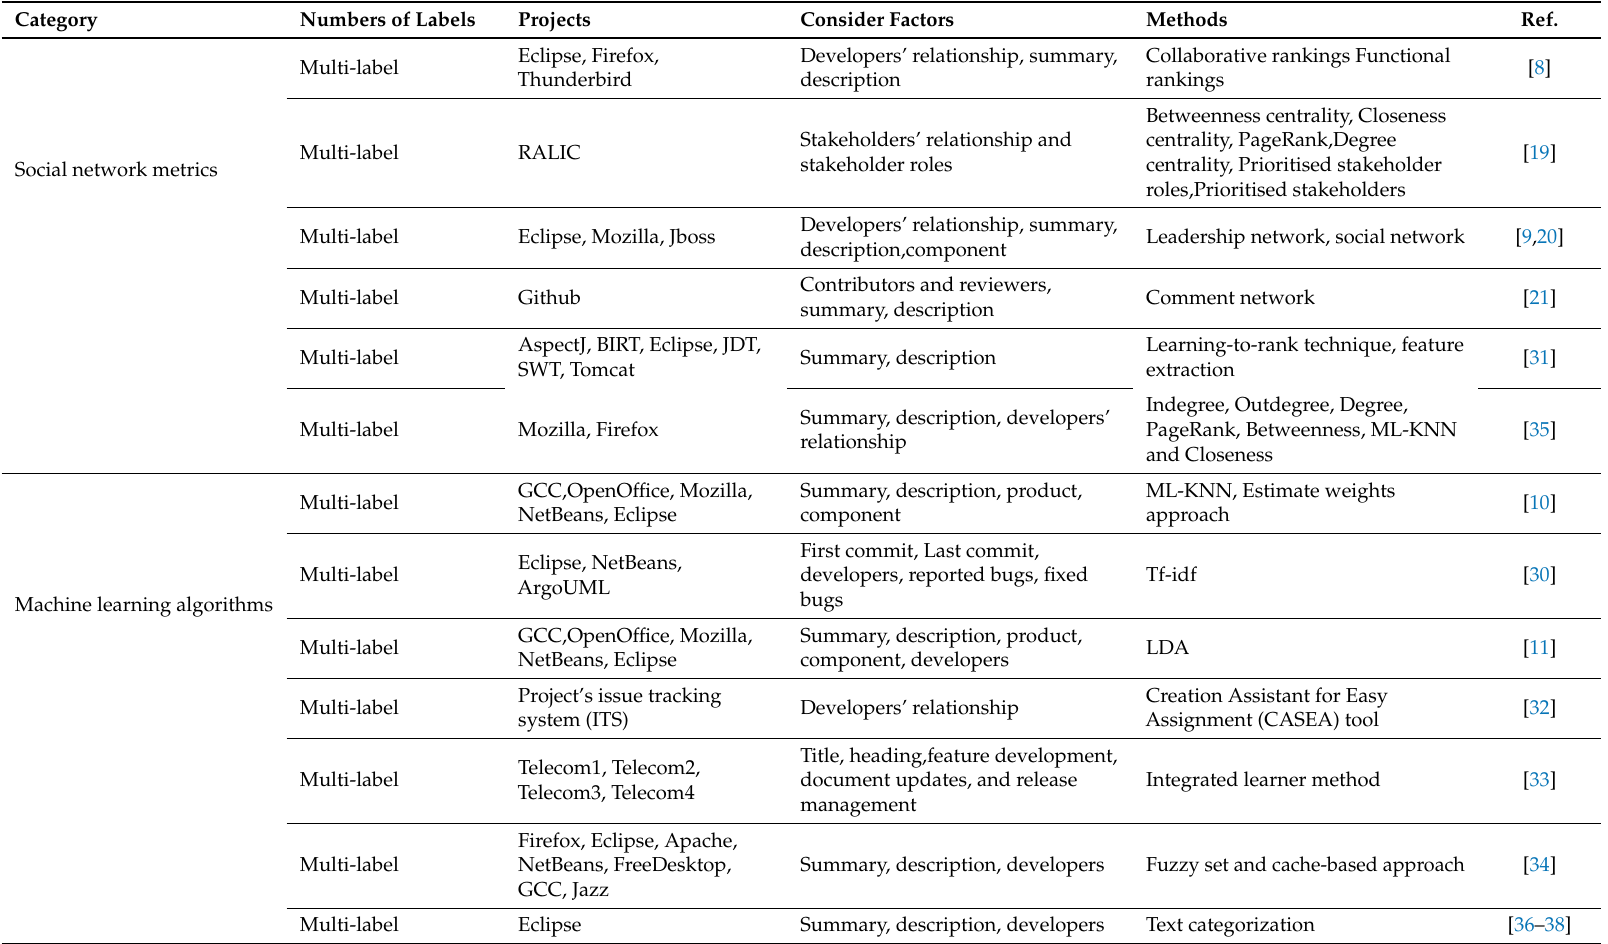
Table 1. An overview of the related work on bug